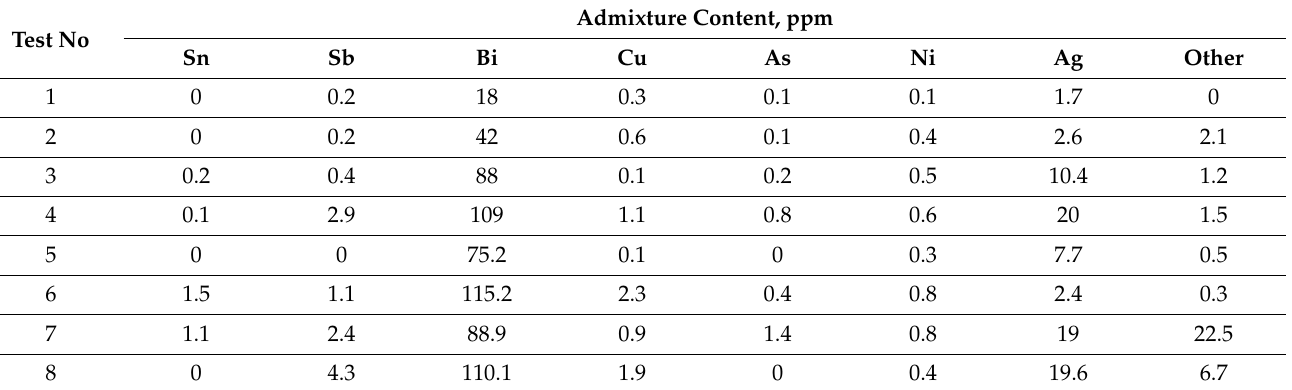
Table 1. Content of main impurities of test lead.